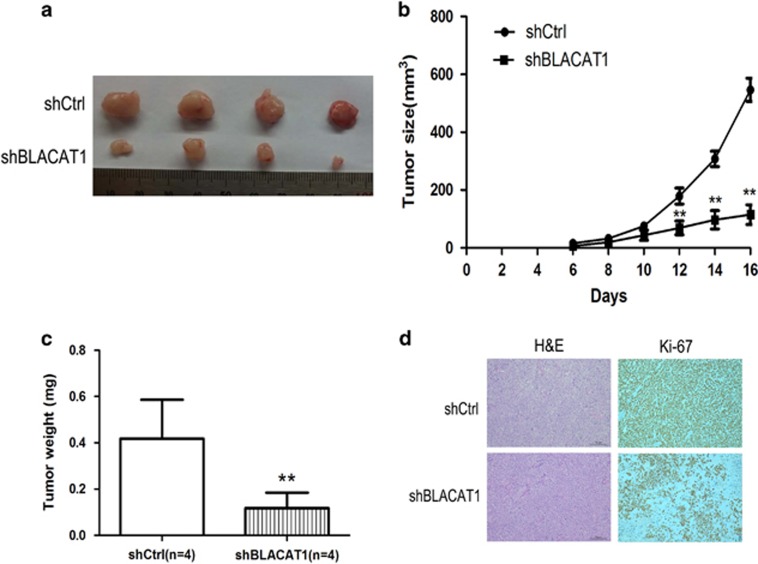
The impact of BLACAT1 on tumorigenesis in vivo. (a and b) Scramble or shBLACAT1 was transfected into HCT116 cells, which were injected into nude mice (N=4). The tumor volumes were calculated every 2 days after injection. The bars indicate S.D. (c) The tumor weights were lower than that in the control group. (d) Histopathology of xenograft tumors. The tumor sections underwent H&E staining and IHC staining using antibodies against Ki-67. Bar, 100 μm. Error bars indicate means±S.E.M. **P<0.01